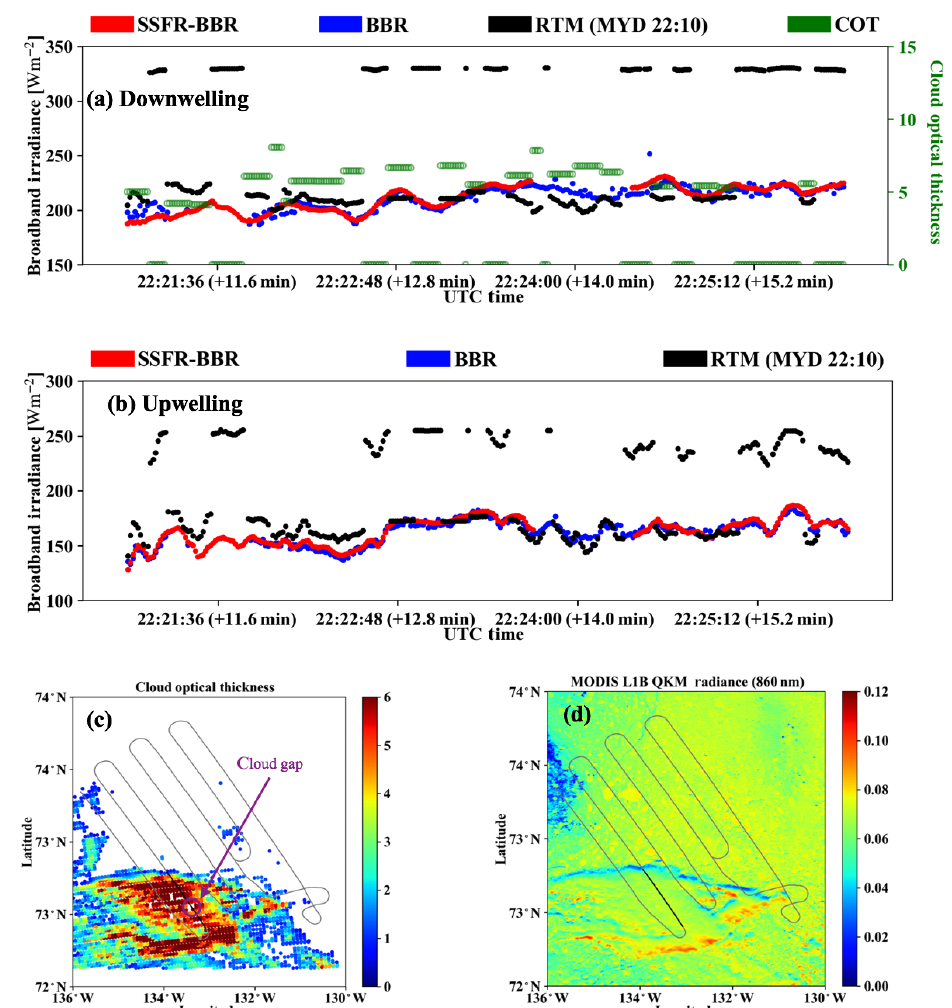
Figure 9. Broadband (a) downwelling and (b) upwelling irradiance from SSFR–BBR, BBR, and MODIS COPs (Aqua MODIS at 22:10) RTM calculations on 13 September (below clouds). The time difference between aircraft measurements and MODIS granule is indicated on the axis labels. In addition, the field of cloud optical thickness and radiance at 860nm from MODIS are provided in (c) and (d) . On the map, the black line indicates the flight track studied in (a) and (b) . The average flight altitude was 235m, and the average aircraft ground speed was 106ms − 1